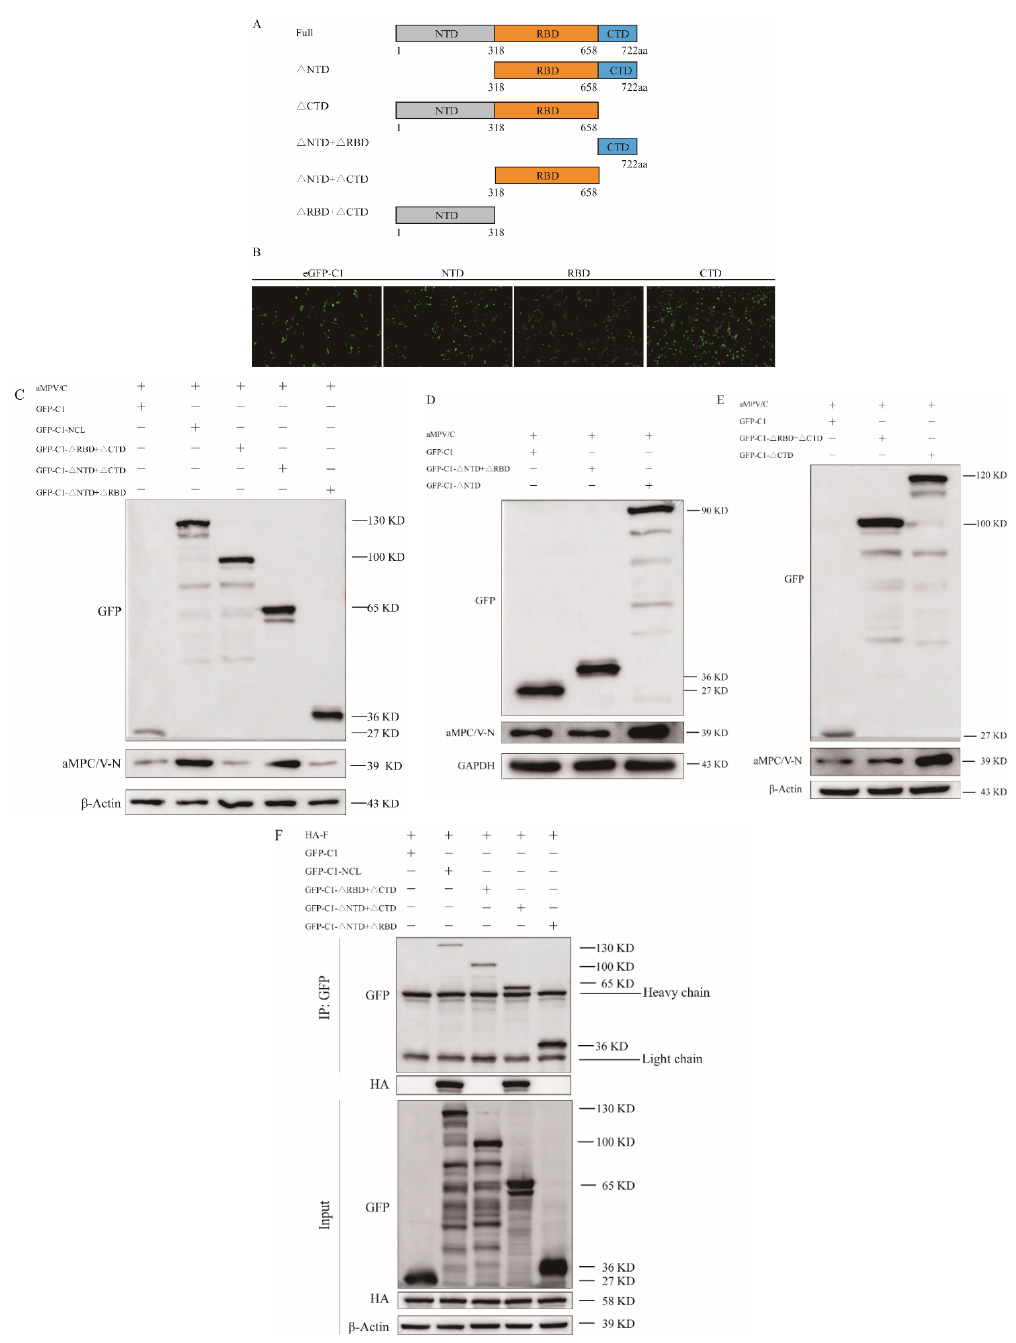
Figure 6. The central domain of NCL plays a critical role in viral replication. ( A ) The structural representation for constructing full − length GFP − tag NCL and NTD, RBD, CTD, NTD − deficiency, and CTD − deficiency domains of NCL. ( B ) After 24 h of transfection with GFP − tag NTD, RBD, and